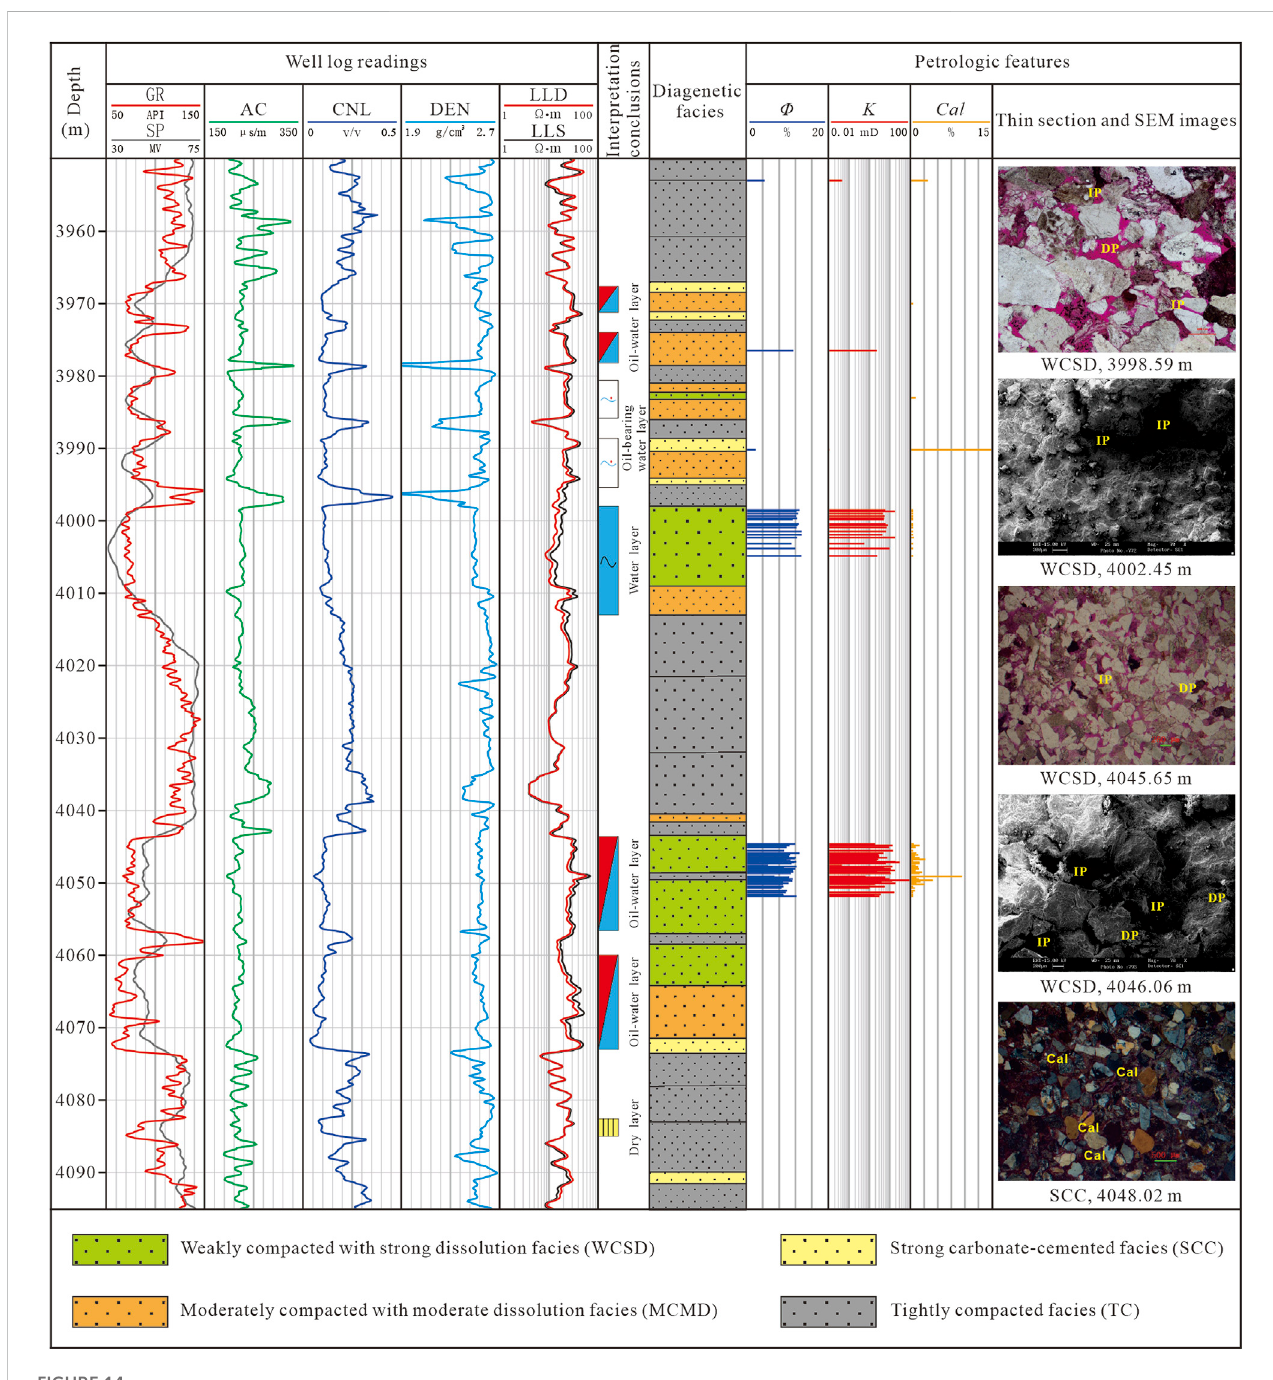
FIGURE 14 Prediction of diagenetic facies in the vertical pro fi le of well H803. Φ -core porosity; K -core permeability; Cal -carbonate cement.